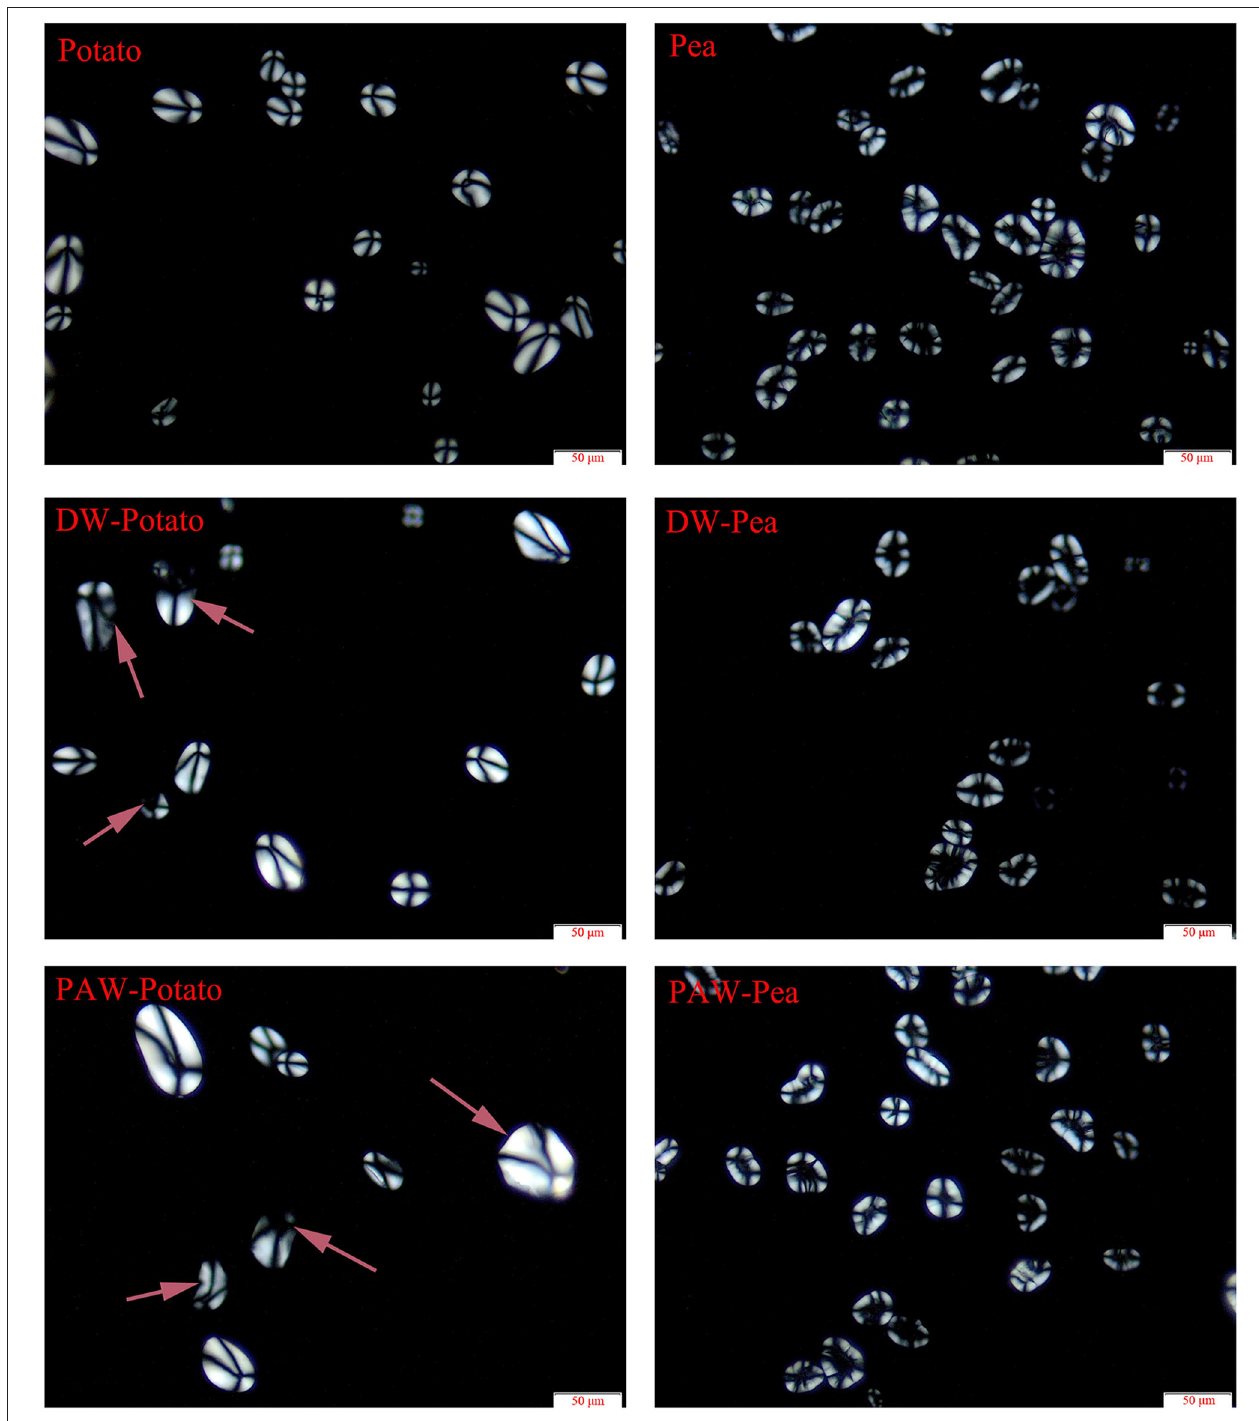
FIGURE 2 | Polarized light microscopy (PLM) images of native and modified starches.